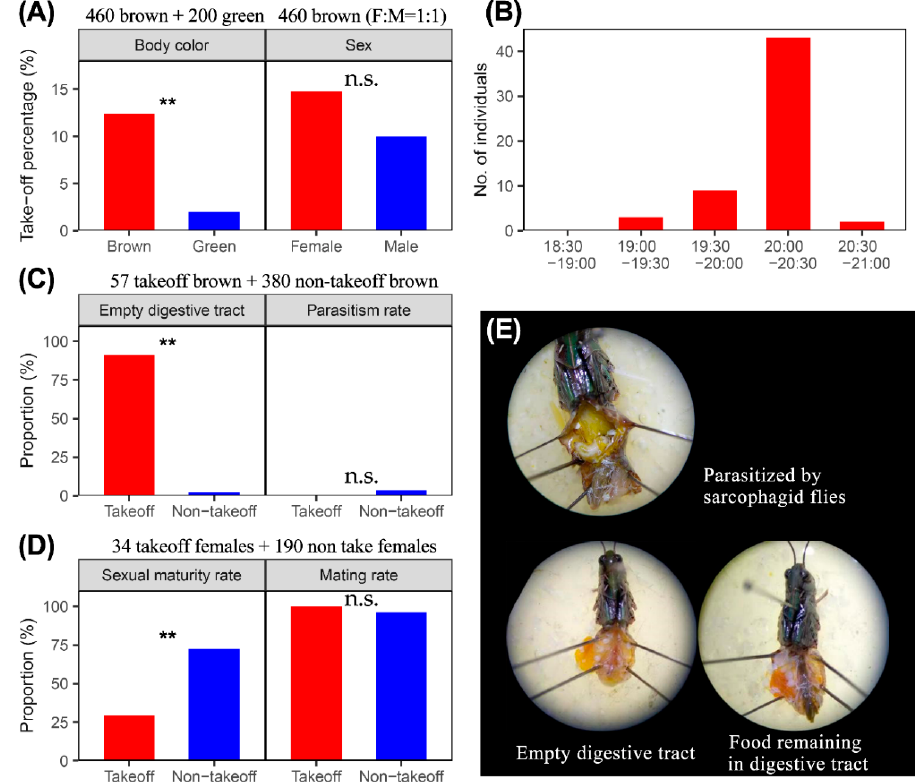
Figure 1. Take-off observation of Oedaleus asiaticus in field cages in inner Mongolia, northern China. ( A ) Take-off percentage between different body colour morphs, and between sexes; ( B ) Take-off numbers at different time periods; ( C ) Proportions of individuals with empty digestive tract or parasitized among take-off and non-take-off groups; ( D ) Proportions of individuals that had reached “sexual maturity” (Level III ovarian development or above) or mated among take-off and non-take-off groups; ( E ) Dissected adult grasshoppers showing parasitism by a sarcophagid fly, an adult with an empty digestive tract, and an adult with food remaining in the digestive tract; “**”=significant, p < 0.01; “n.s.” = not significant.